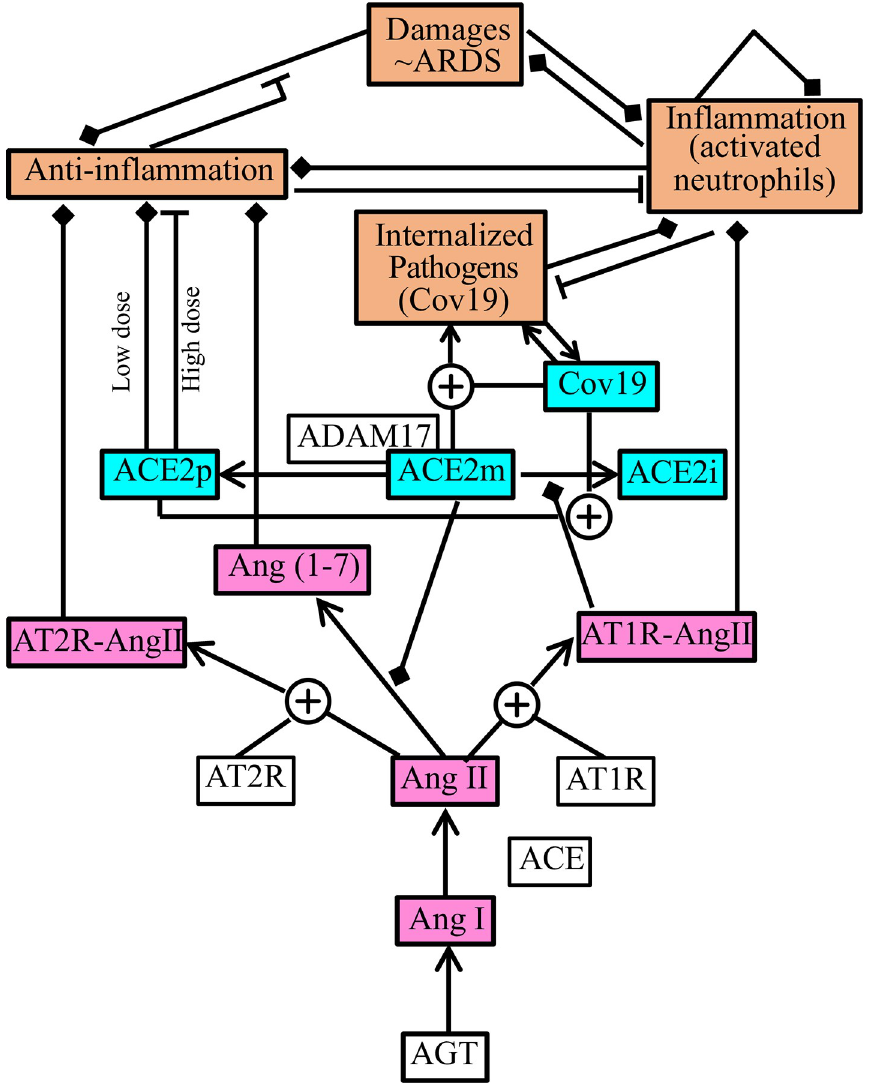
Fig 1. Schematic model diagram. Orange boxes, inflammatory response; blue boxes, angiotensin converting enzyme 2 (ACE2) dynamics; purple boxes, renin-angiotensin system; white boxes, model parameters. Arrows represent conversion; square end, activation; flat end,